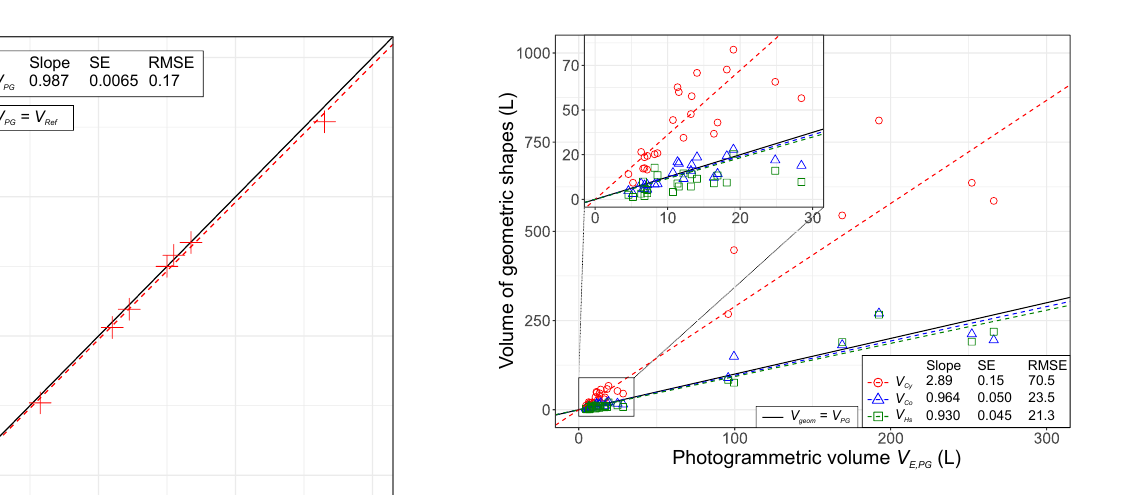
Figure 3. Comparison of TM epigeal volumes V E measured by pho- togrammetry (PG) and approximated by three geometric shapes, a cylinder (in red), a cone (in blue) and a hemi-spheroid (in green; Fig. 1). The volumes of the geometric shapes are based on the same basal radius r B , estimated by measuring the basal circumference of the TM. By comparing the regression slopes and considering PG as the reference method, volumes were overestimated by 190 ± 15% using the cylinder, and underestimated by 3.6 ± 5 and 7.0 ± 4.5% using the cone and hemi-spheroid,